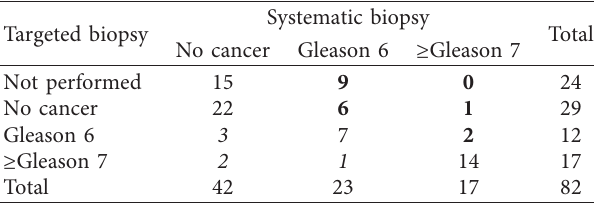
Table 2: Whole group pathology outcomes of systematic biopsy and targeted biopsy.